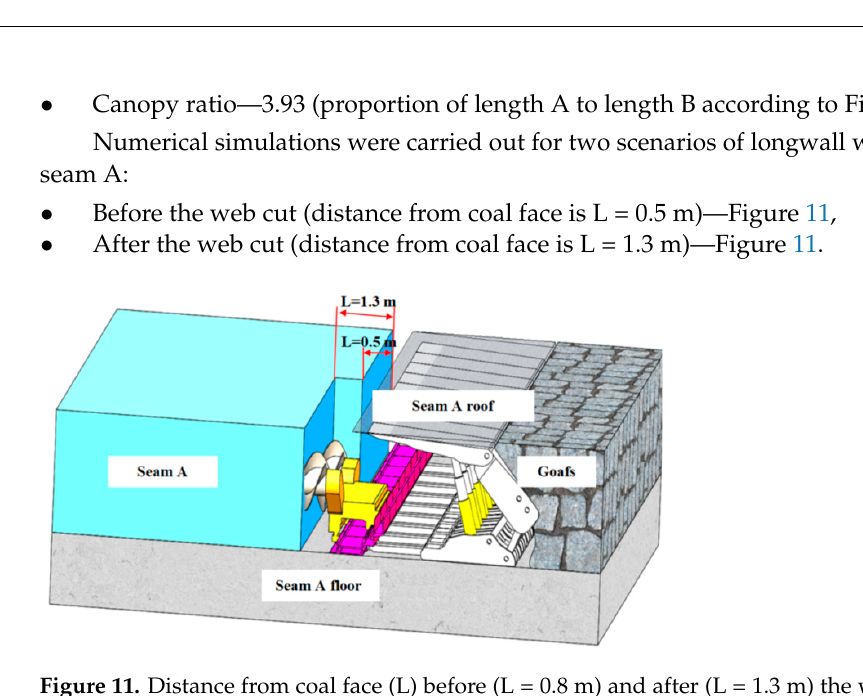
Table 4. Results of numerical simulation.